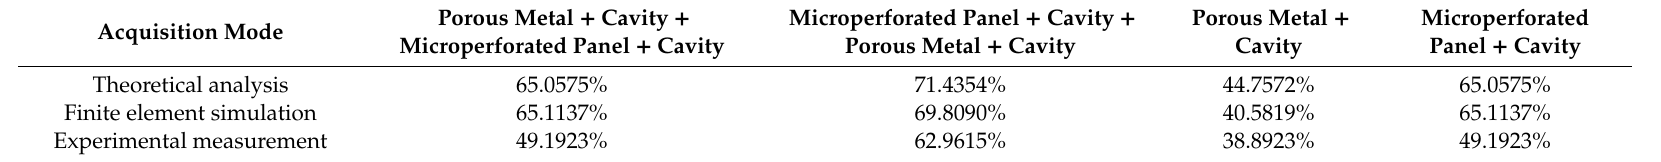
Table 4. The average sound absorption coe ffi cients when the limited total thickness was 30 mm.